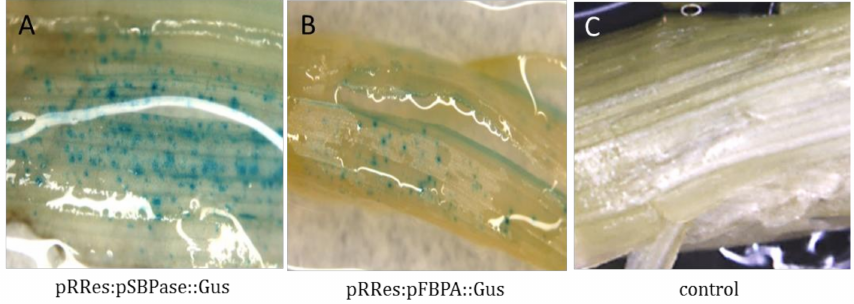
Figure 3. Histochemical GUS assay for transient expression of B. distachyon SBPase and FBPA promoters in wheat leaves. The transient assays were performed by particle bombardment of young wheat leaves which were incubated at 22 ◦ C in 12 h/12 h light/dark for 48 h prior to GUS staining: ( A ) gus expression driven by the SBPase promoter; ( B ) gus expression driven by the FBPA promoter; ( C ) control leaf bombarded without